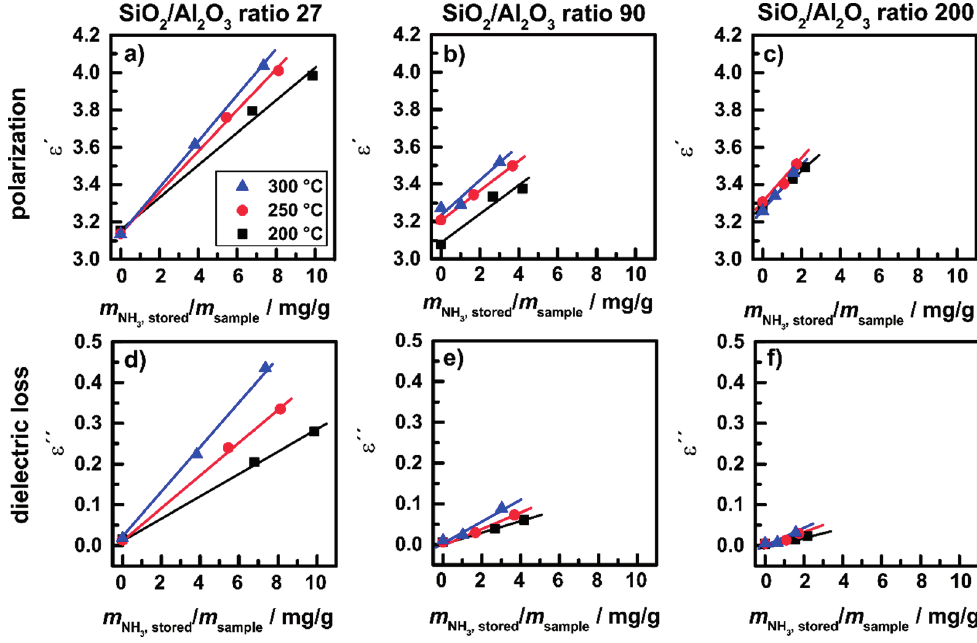
Figure 16. H-ZSM-5 powders: ( a – c ) polarization ε ´; and ( d – f ) dielectric losses ε ´´ over stored amount of NH 3 for powders with different SiO 2 /Al 2 O 3 ratios at 200, 250 and 300 °C. Reprinted from